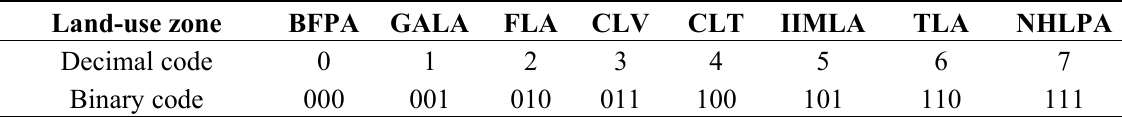
Table 7. The coding of the land-use